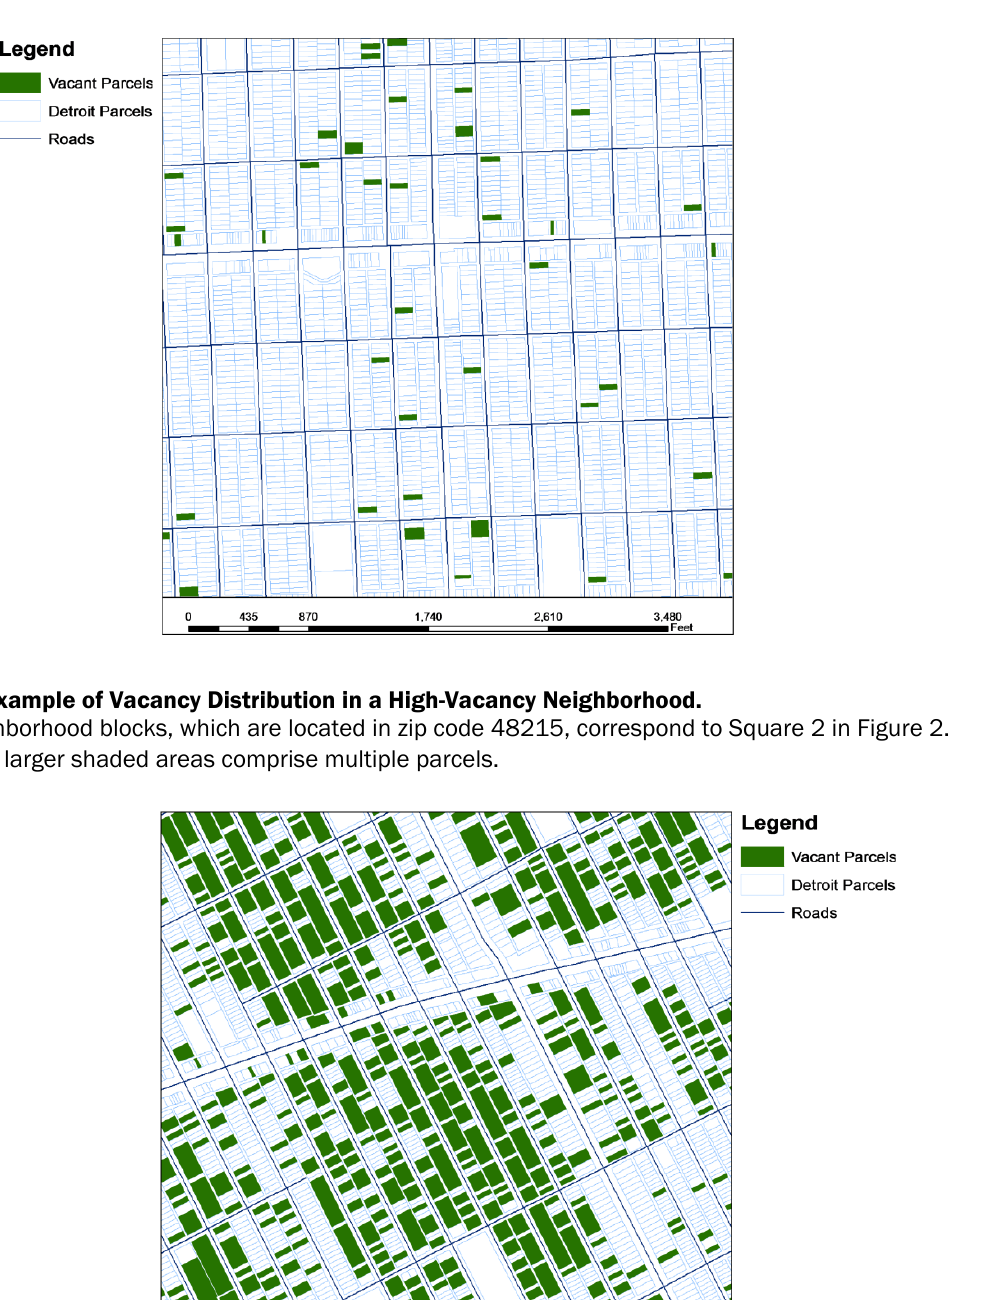
Figure 3. Example of Vacancy Distribution in a Low-Vacancy Neighborhood. These neighborhood blocks, which are located within zip code 48228, correspond to Square 1 in Figure 2.